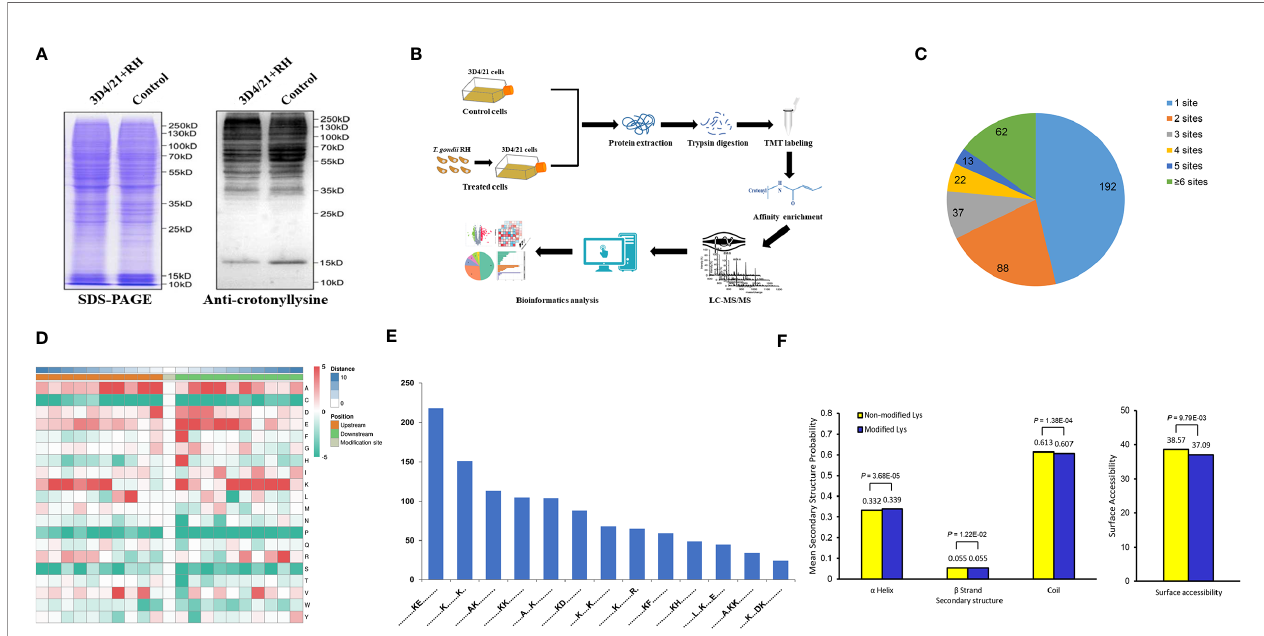
FIGURE 1 | Global analysis of Kcr proteome in porcine alveolar macrophages. (A) SDS-PAGE and Western blot analysis of the total protein content of porcine alveolar macrophages infected with T. gondii and the control group probed with anti-crotonyllysine. (B) Schematic representation of experimental work fl ow for TMT quanti fi cation of Kcr in 3D4/21+RH and control cells. (C) Pie chart revealing the distribution of the number of identi fi ed Kcr sites per protein. (D) Heat map showing the frequency of the different of amino acids around the Kcr. (E) Number of the crotonylated peptides in each motif. (F) Distribution of lysine crotonylation in different protein secondary structures and the predicted surface accessibility of Kcr